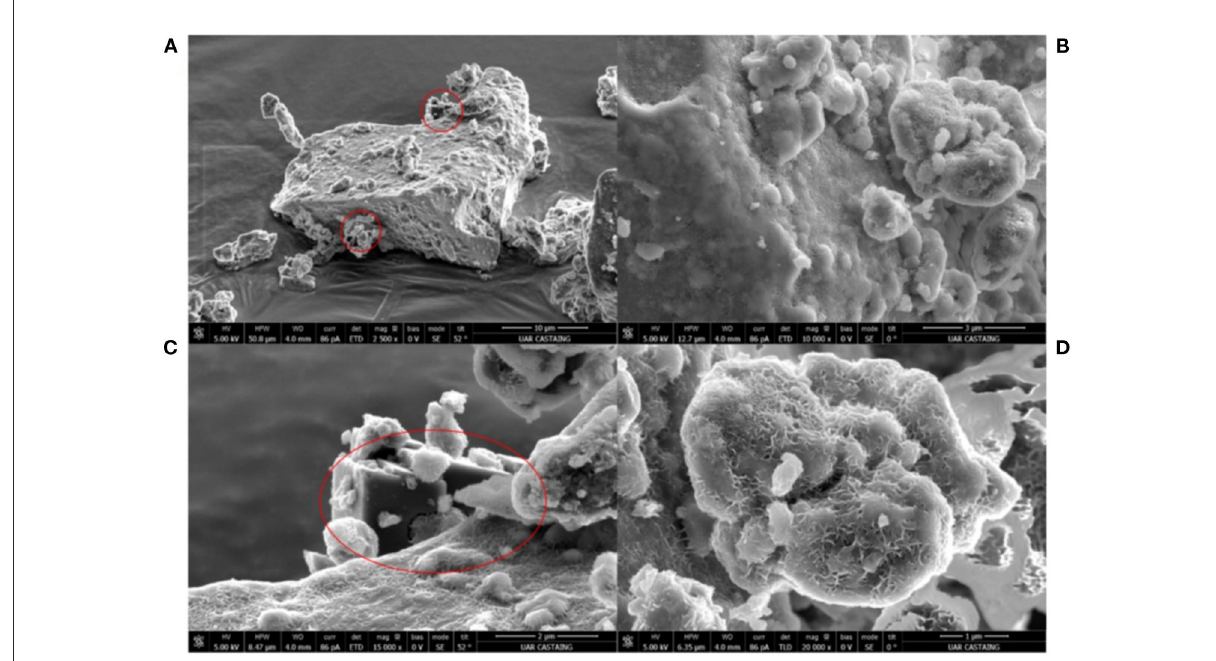
FIGURE6 SEM images of reaction products from C mode after 24h of reaction covered with a Si-rich passivation layer: (A) low resolution, (B–D) high resolution (red circle: carbonates).